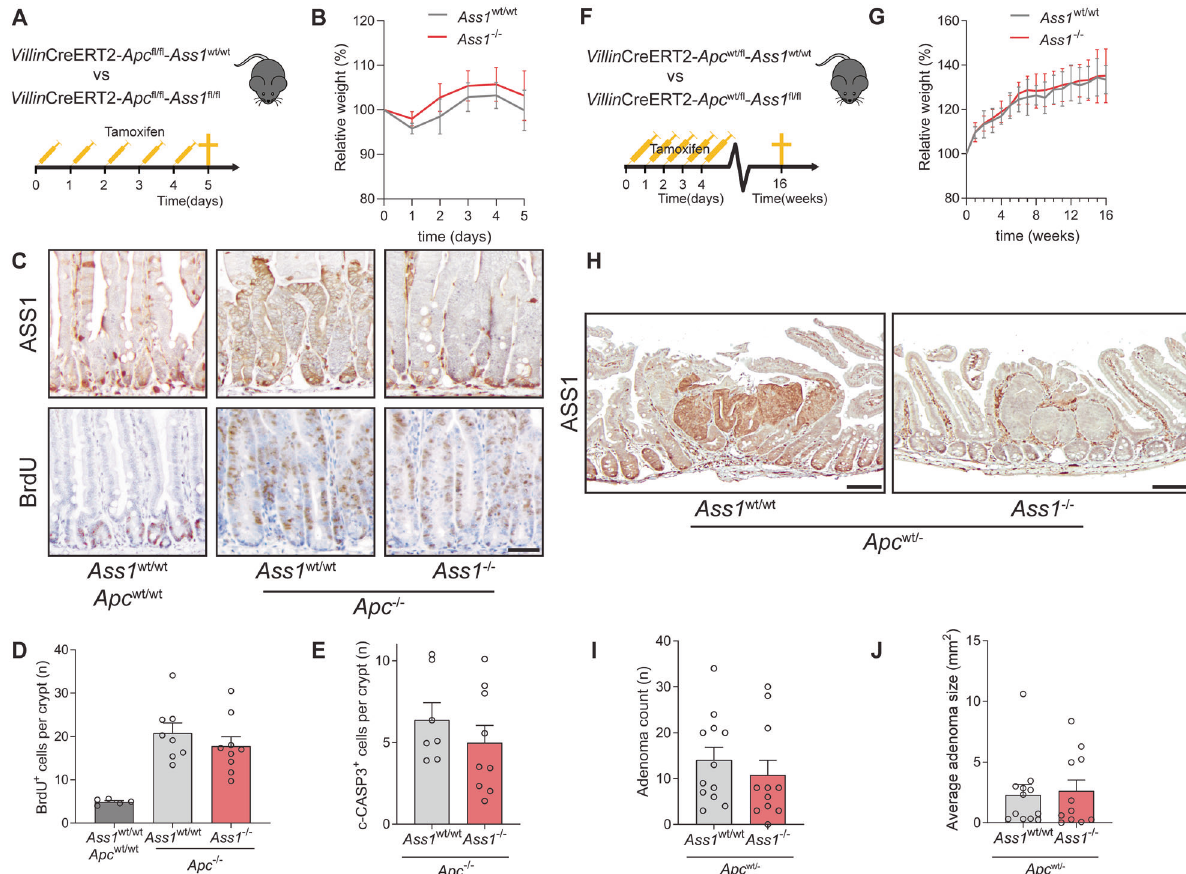
Fig. 5 Ass1 knockout in the intestinal epithelium does not affect tumorigenesis in vivo. A Schematic overview of the Apc fl / fl mouse model. B Relative weight compared to start tamoxifen injections. C Immunohistochemistry for ASS1 (upper panels) and BrdU (lower panels) of Ass1 wt/wt and Ass1 − / − mice 5 days after recombination. Representative images are shown. Scale bar represents 50µm. D Amount of BrdU-positive cells per crypt in the small intestine. E Amount of cleaved caspase-3-positive cells per crypt in the small intestine. F Schematic overview of the Apc wt/ fl mouse model. G Relative weight compared to start tamoxifen injections. H Immunohistochemistry for ASS1 in adenomas in Ass1 wt/wt and Ass1 − / − mice. Scale bar represents 100µm. I Amount of adenomas in both groups. J Average adenoma